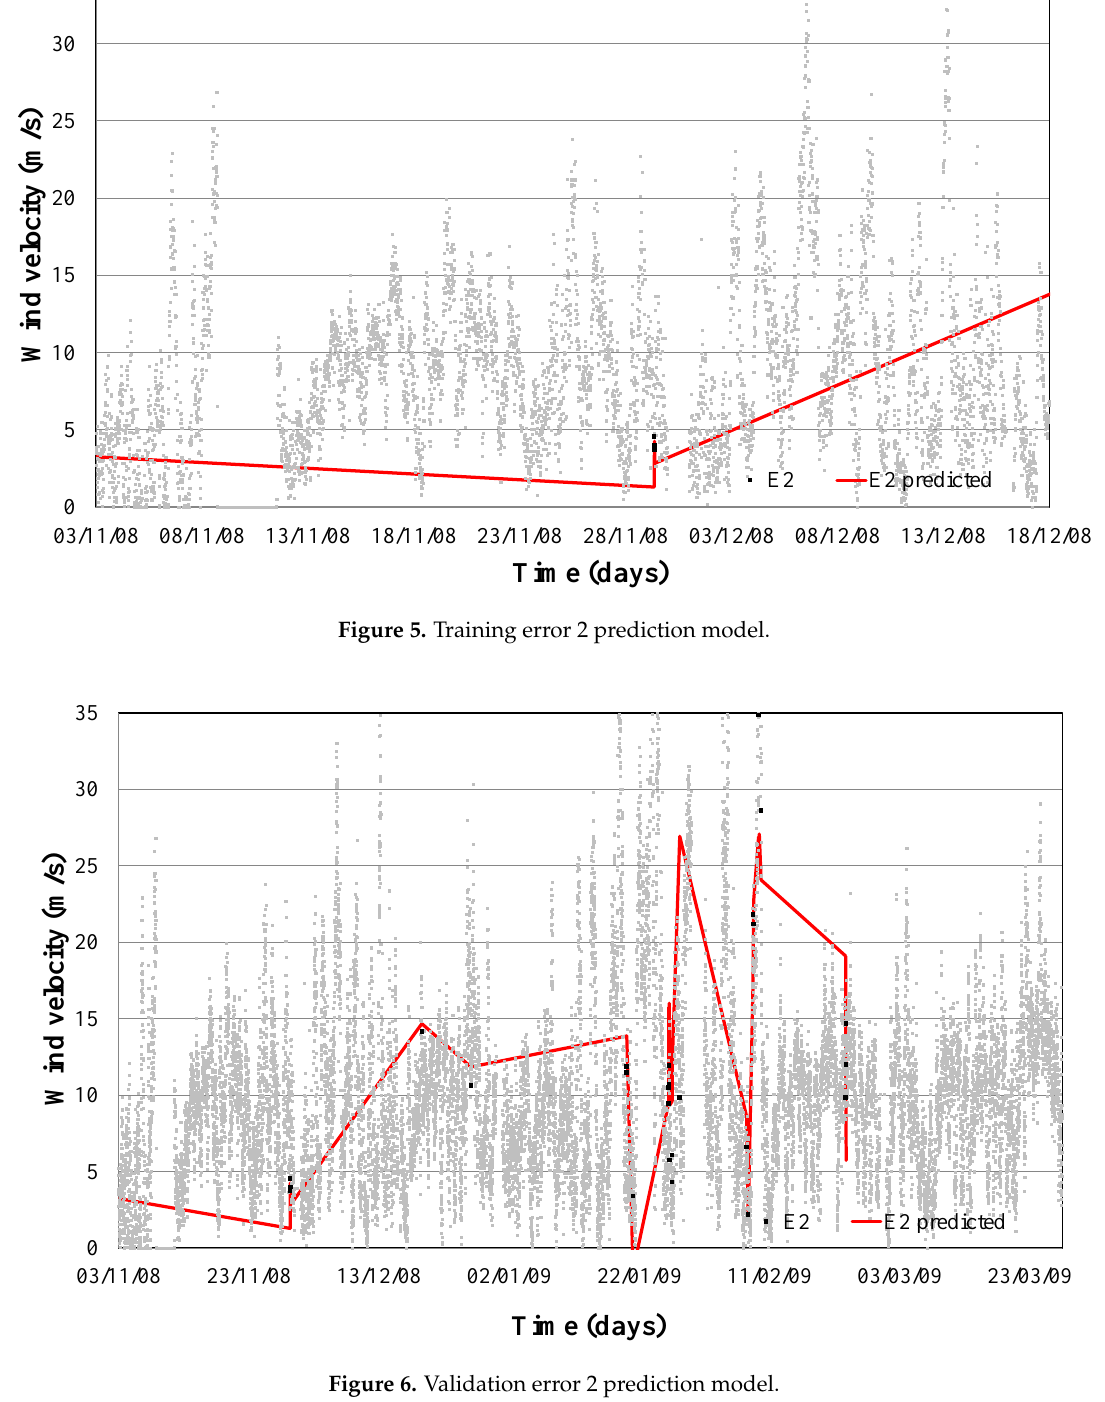
Figure 7. Maximum wind velocity for error 1 (E1) at different relative humidity and error 2 (E2).